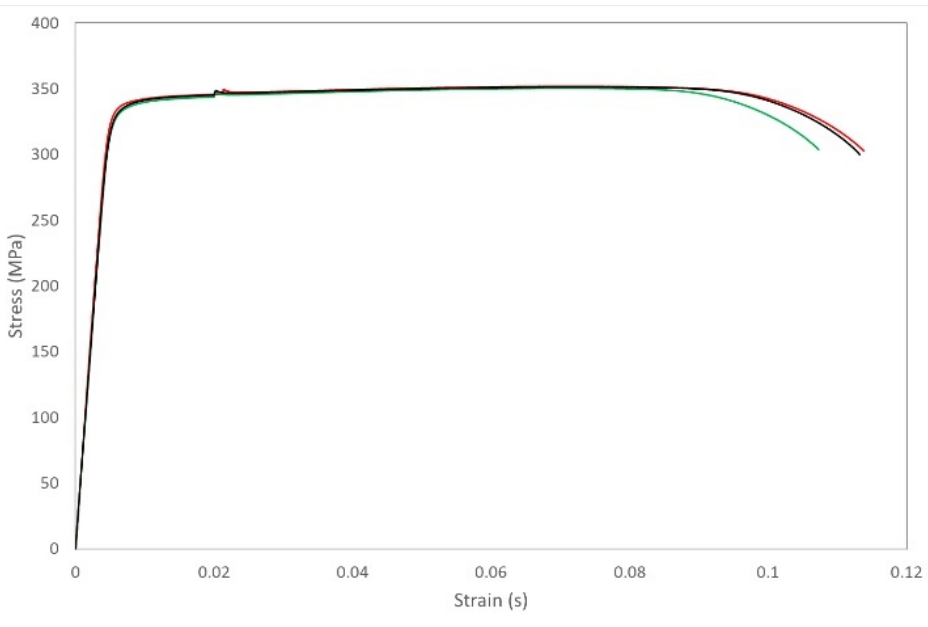
Figure 6. Flow curves of AA6010 following aging heat treatment.